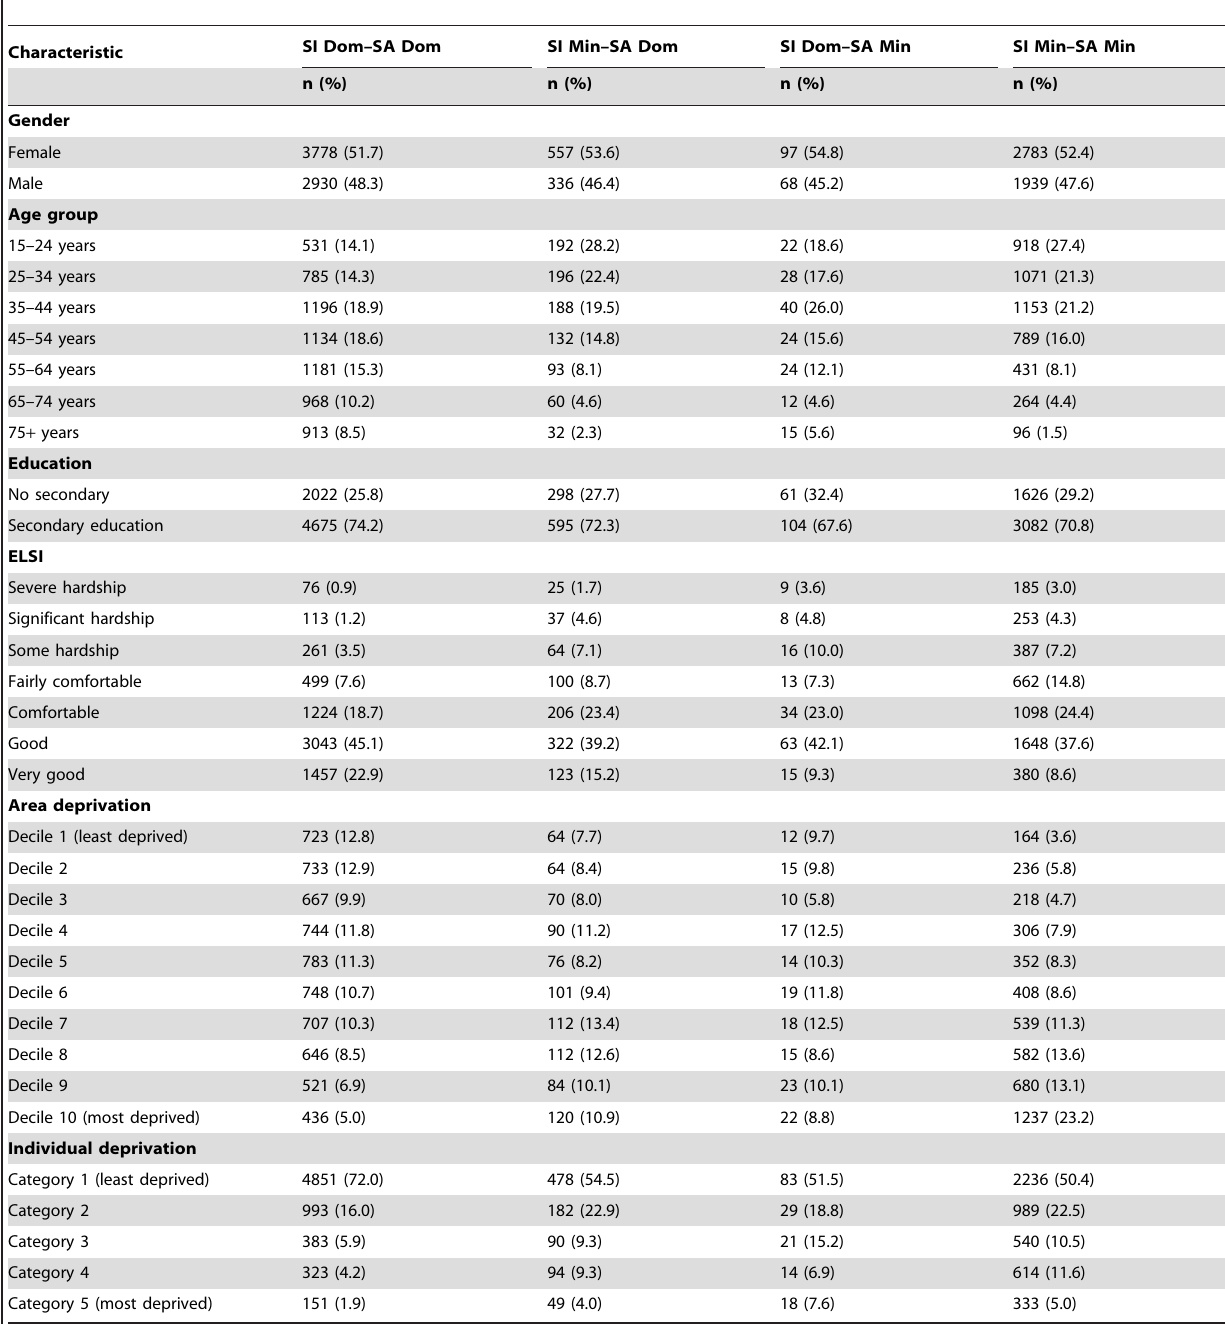
Table 3. Socio-demographic characteristics of the four self-identified–socially-assigned analytical categories (weighted